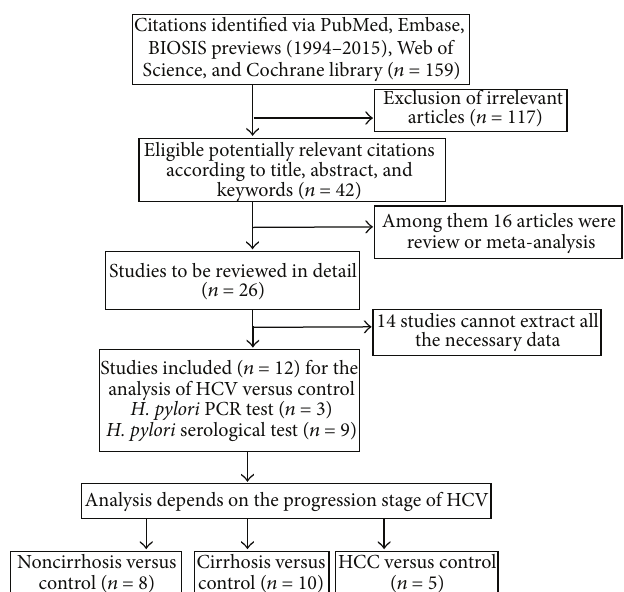
Figure 1: Flow diagram of study selection and analysis. HCV: hepatitis C virus; HCC: hepatocellular